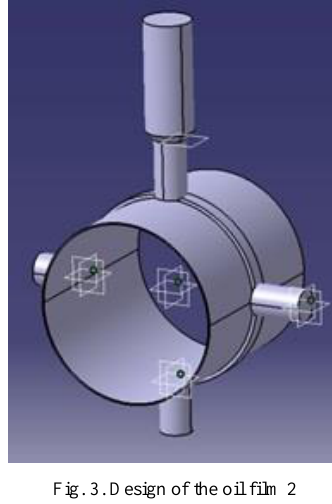
Fig. 3. Design of the oil film 2